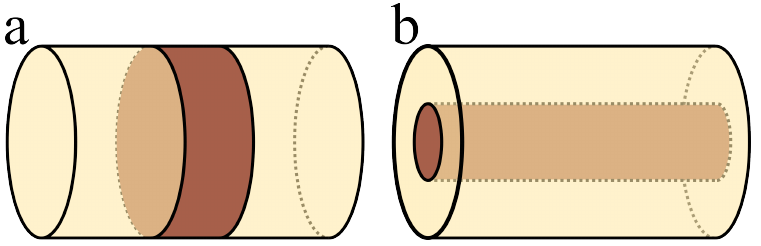
Figure A1. Cylindrical target (brown) embedded in a medium (yellow). ( a ) The embedded body completely fills the cross-section. ( b ) The embedded body has the same length as the surrounding cylinder of the